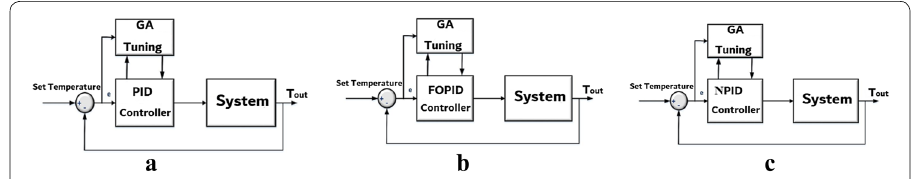
Fig. 7 Block diagram of GA control tuning system: a PID controller, b FOPID controller, c NPID controller